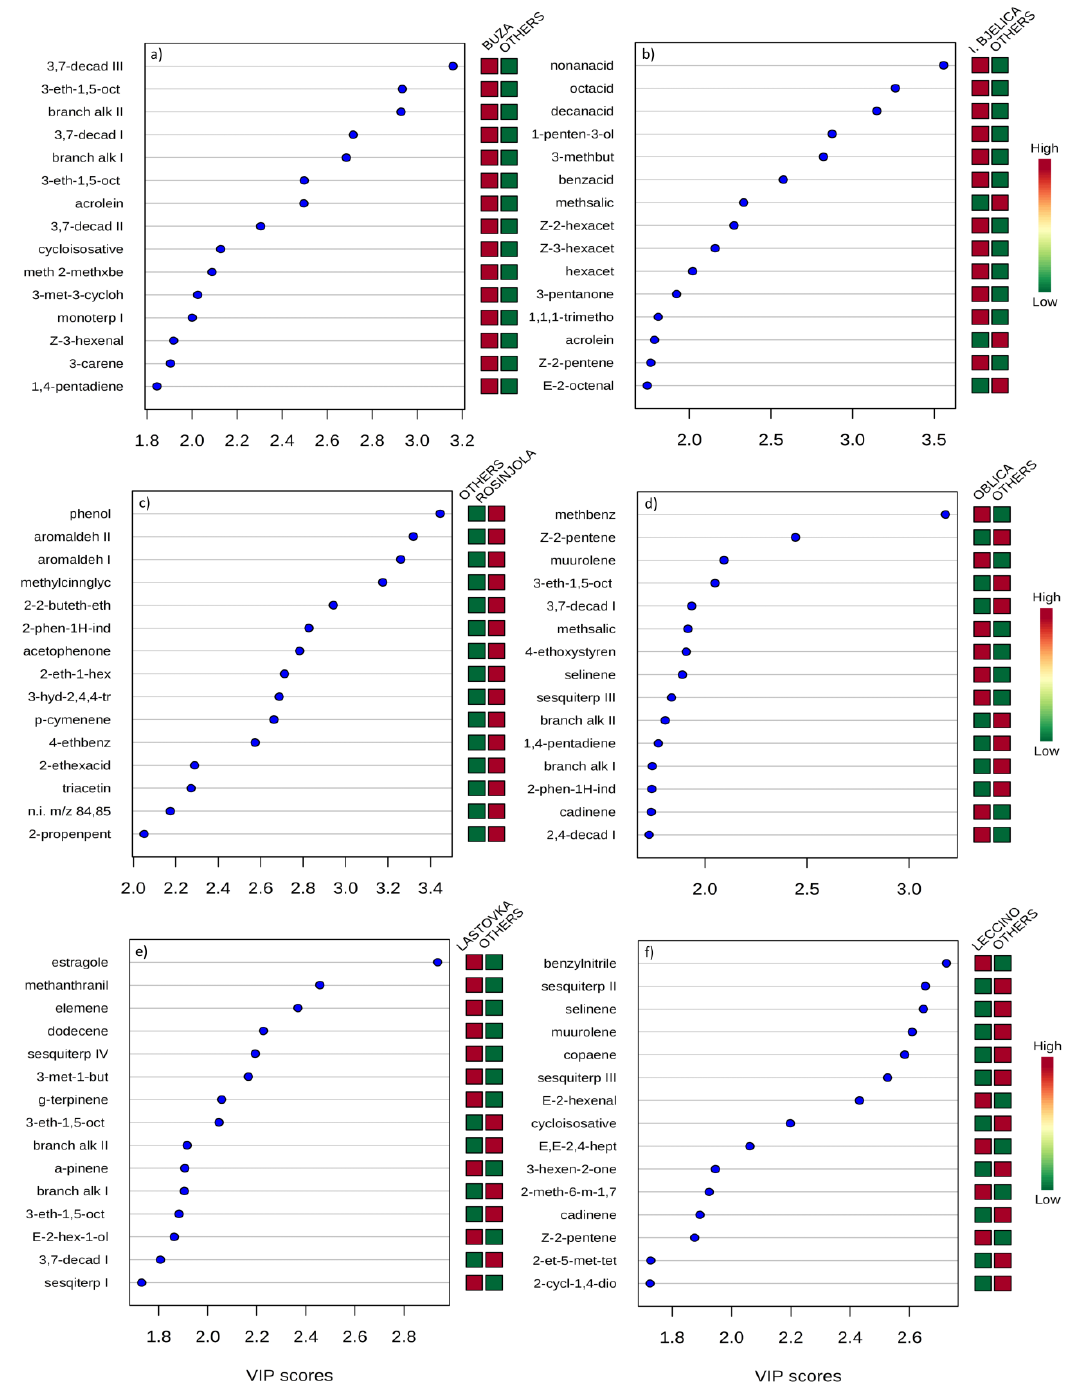
Figure 2. Variable Importance in Projection (VIP) scores of the variables (volatile compounds) most useful for the differentiation of each monovarietal extra virgin olive oil (EVOO), specifically: ( a ) Buža, ( b ) Istarska bjelica, ( c ) Rosinjola, ( d ) Oblica, ( e ) Lastovka, and ( f ) Leccino from the other five EVOOs produced in Croatia. Variables were extracted by partial least squares discriminant analysis applied on mean-centered data of six separate datasets each including two groups (a single vs. other five monovarietal EVOO).